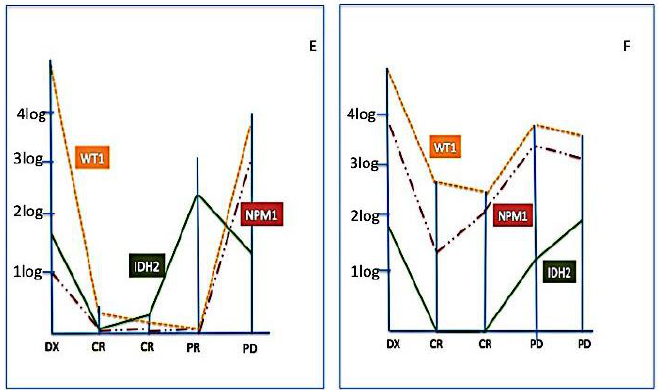
Figure 3. IDH2 mutation monitoring in complete remission (CR). In these four cases (#A, #B, #C, #D), IDH2 mutations well correlated with the clinical response; in these patients IDH2 might be considered as a good marker for minimal residual disease (MRD).